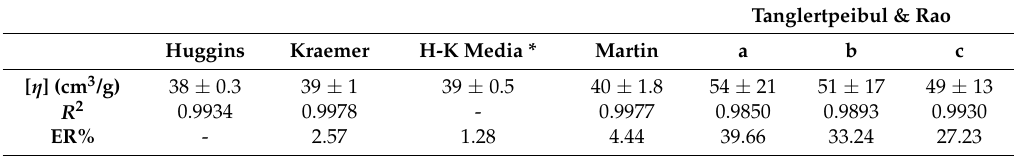
Table 1. Intrinsic viscosity by different methods.